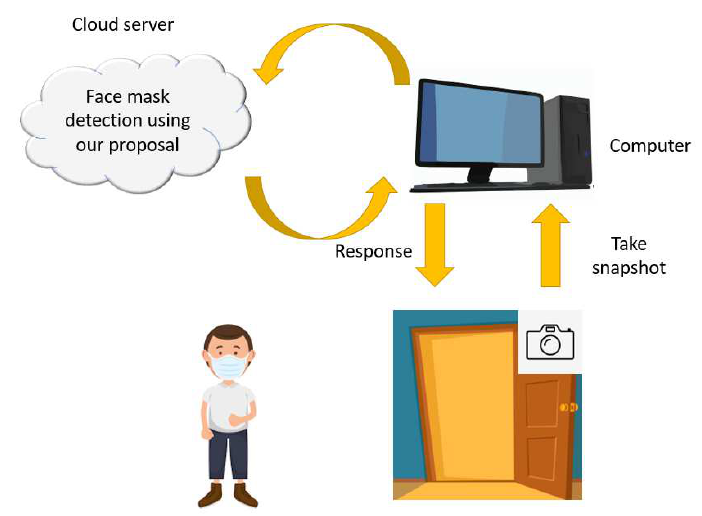
Figure 9. Mask sensitive automatic door.